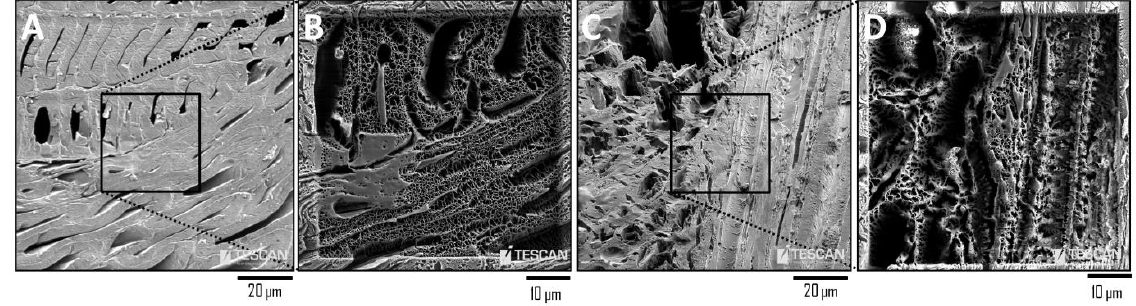
Figure 2. Selected area of interest (AOI) SEM of a spruce particle interphase prior ( A ), and crater-formations due to the TOF-SIMS analysis ( B ). AOI of a cup-plant particle interphase prior ( C ) and crater formations due to the TOF-SIMS analysis ( D ).